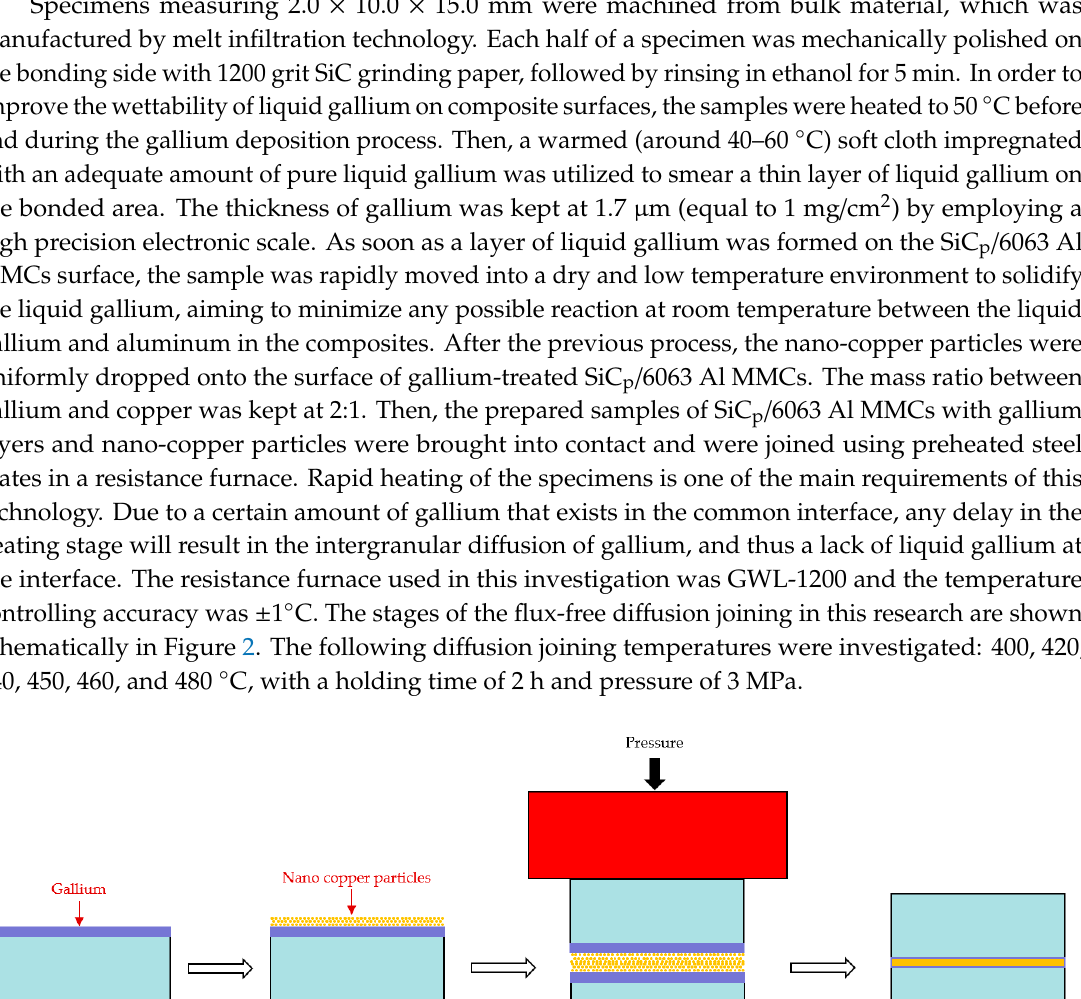
Figure 2. Schematic diagram of the flux-free diffusion joining of SiC p /6063 Al MMCs.